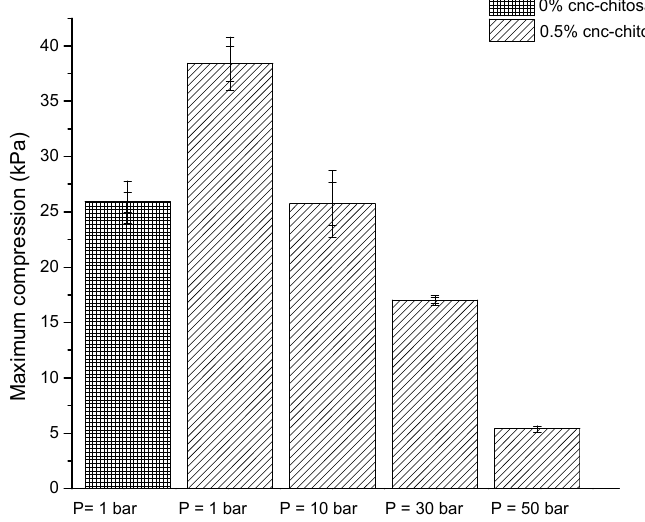
Figure 1. Maximum compression of hydrogels formed at different pressure conditions.